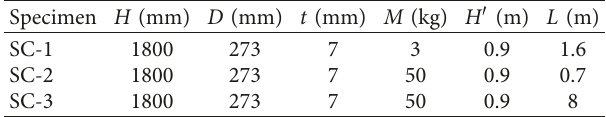
Table 6: Parameters of the CFST column blast test.